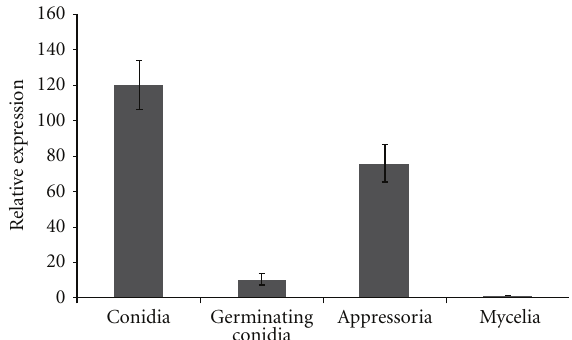
Figure 2: Expression level of CgPKAC in di ff erent morphological cells; conidia, germinating conidia, appressoria, and mycelia. 18S rDNA was used as a reference gene and the expression of CgPKAC in di ff erent morphological cells was compared to the level of its expression in the reference sample (mycelia). Statistically significant di ff erences in CgPKAC expression levels between conidia, germinat- ing conidia, appressorian, and mycelia were tested with an ANOVA analysis ( P < 0 .